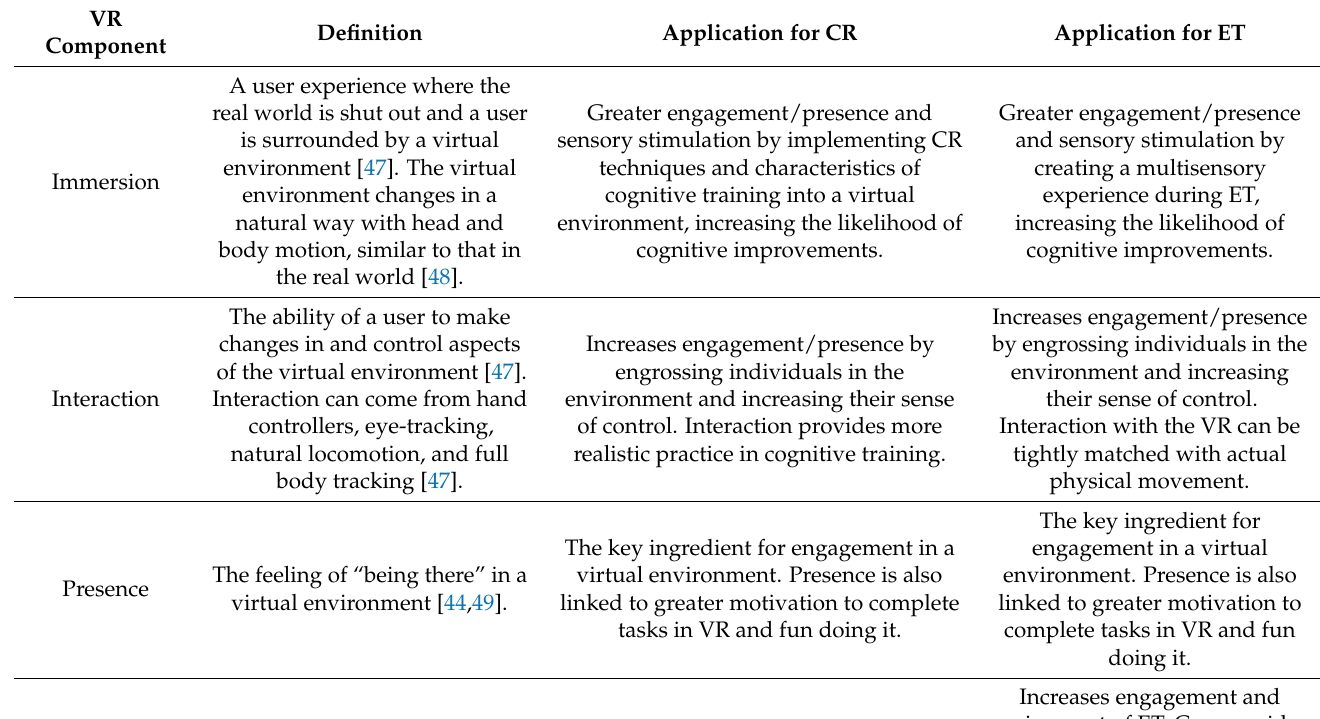
Table 1. VR components that are conducive for inclusion in CR and ET interventions on cognition in